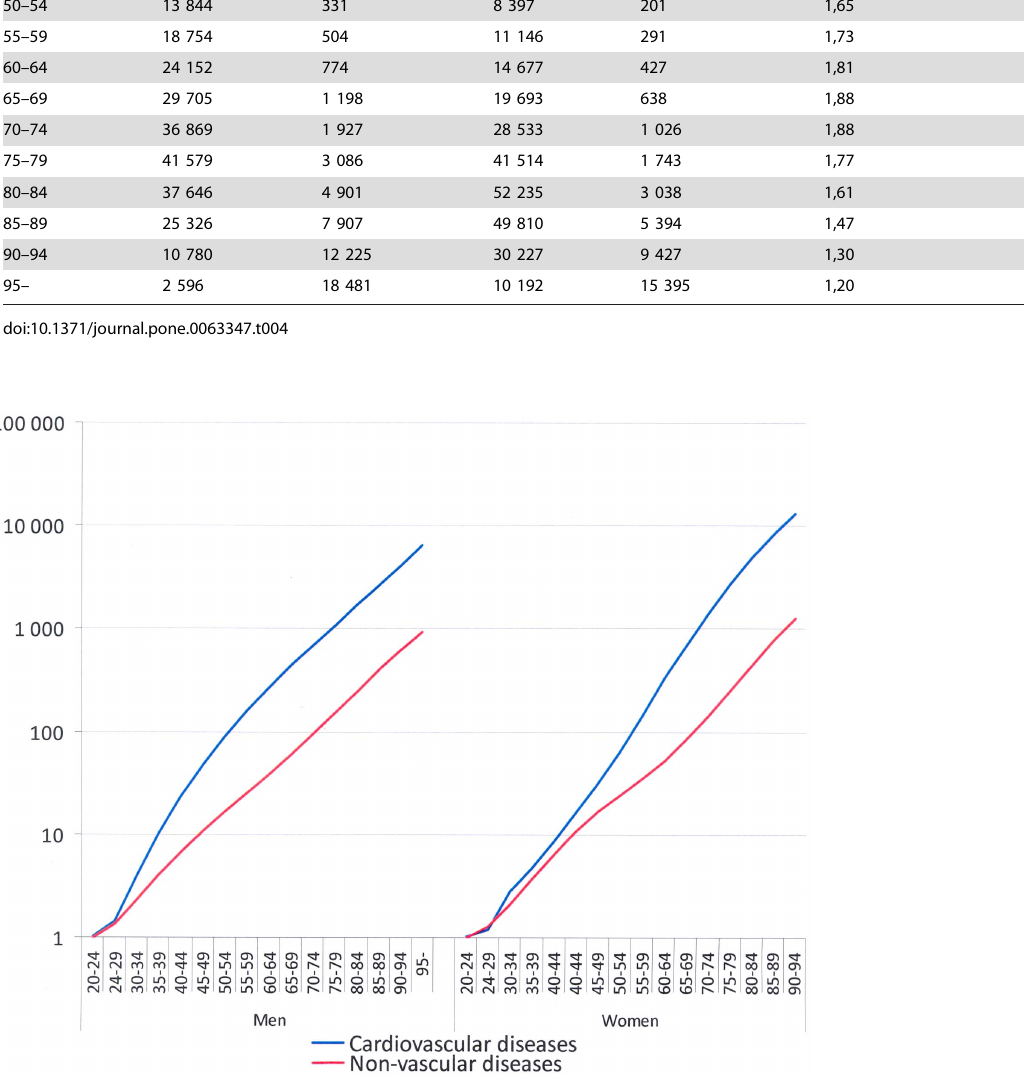
Figure 1. Mortality rates for cardiovascular diseases and non-vascular diseases in five-year age categories expressed on a logarithmic